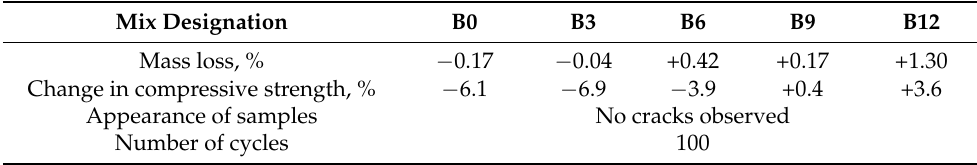
Table 8. Freeze–thaw resistance